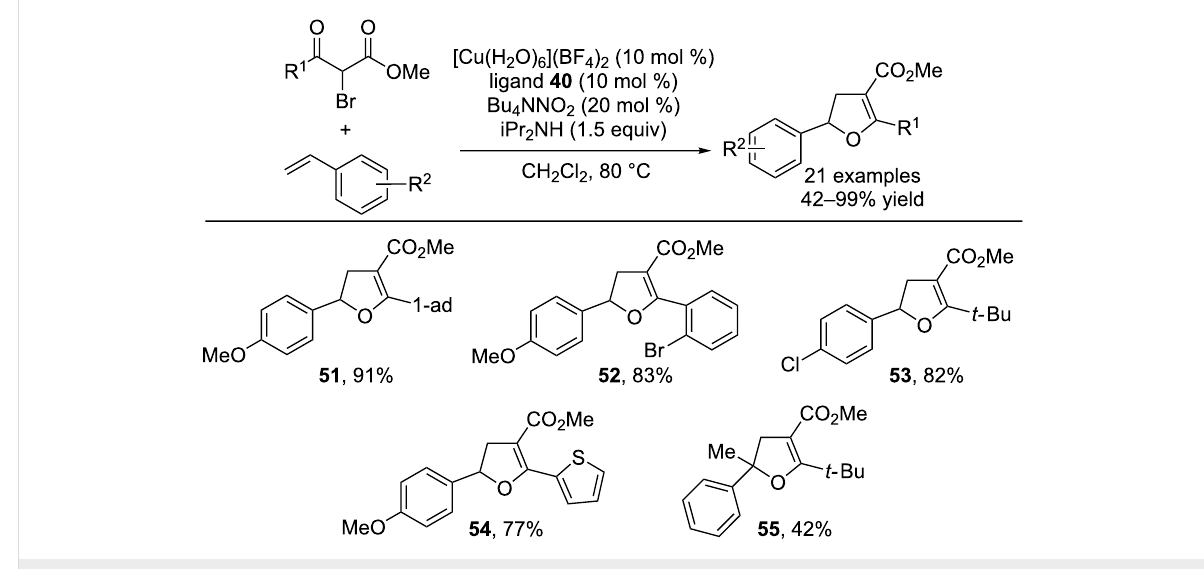
Scheme 15: Scope of the formal [3 + 2] cycloaddition.